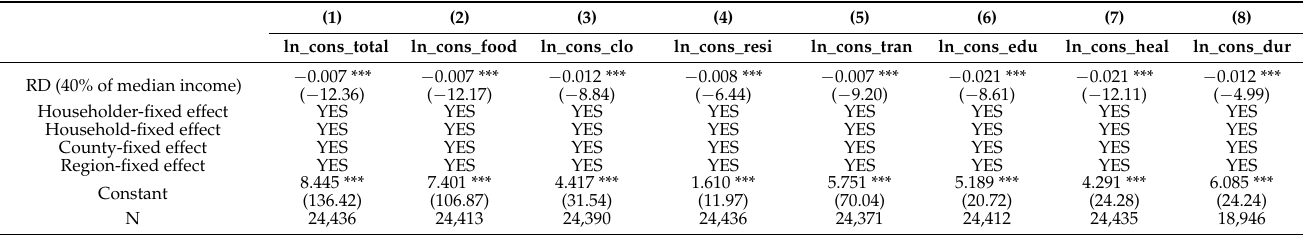
Table 2. Results of the baseline regressions: HDFE model.